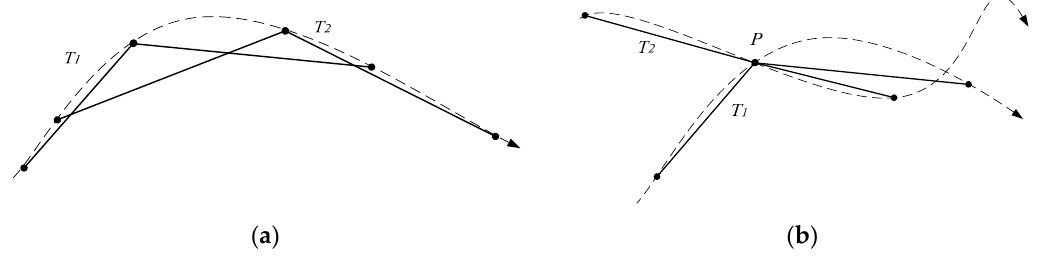
Figure 1. Various point sampling methods of the same trajectory. ( a ) A trajectory of two sampling methods; and ( b ) two trajectories take the same point.